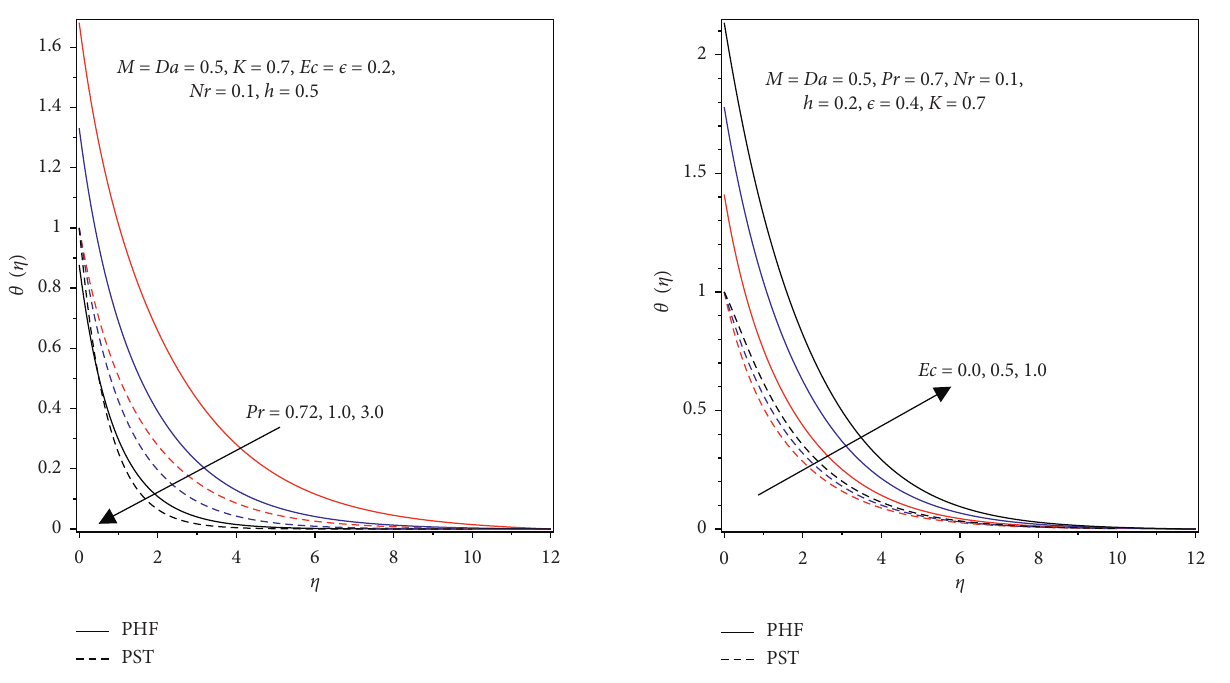
Figure 9: Reaction of temperature field with Eckert number Ec